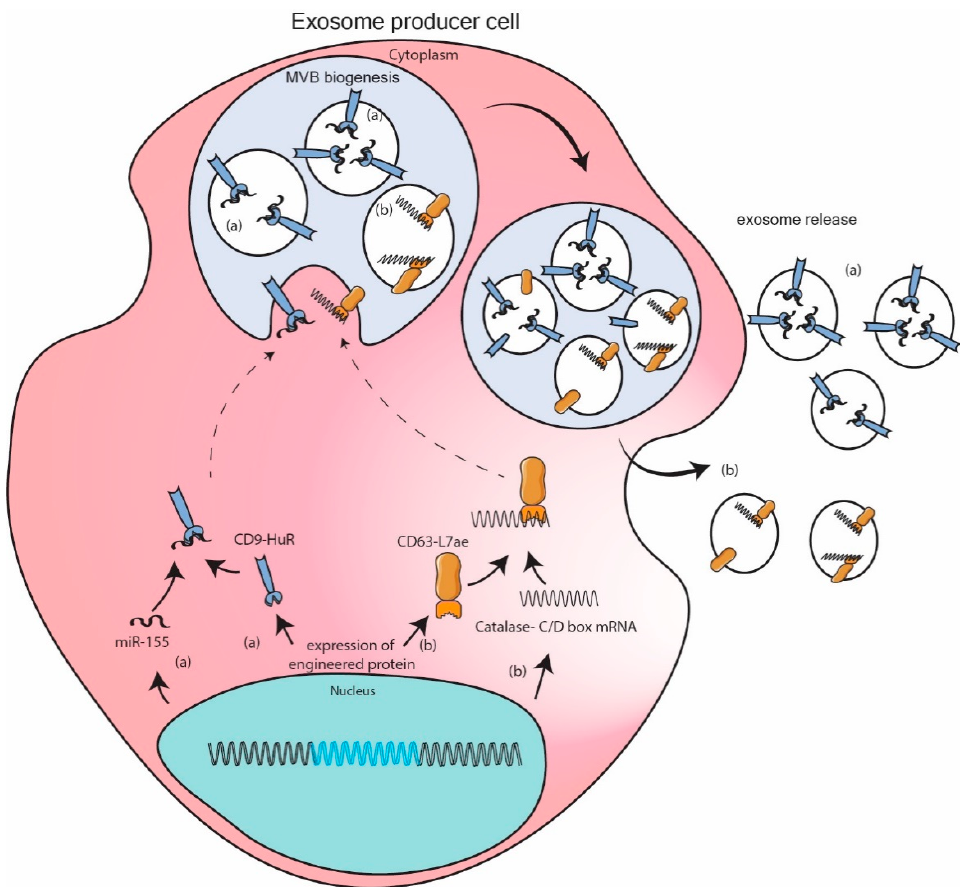
Figure 3. Engineered protein mediated packaging model. Modification of exosome marker protein by fusing them with high affinity RNA binding domain leads to recruitment of specific RNA in exosome. Example depicted here are ( a ) interaction on micro RNA (miR)-155 with HuR fused to exosomal marker protein CD9 enriches miR-155 in exosome. ( b ) catalase mRNA containing C/D box sequence at 3 ′ UTR can bind to L7ae fused to exosomal marker protein CD63 leading to enrichment of catalase mRNA in exosomes.